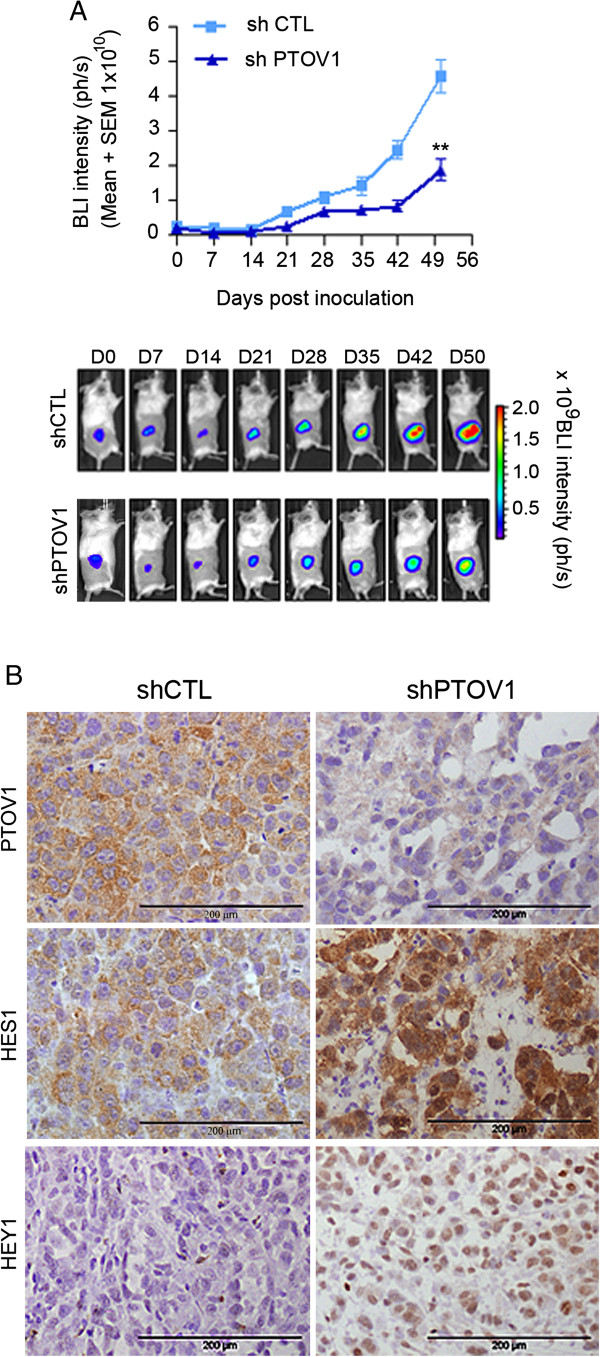
Knockdown of PTOV1 in prostate cancer cells inhibits tumor growth and metastasis of PC-3 cells in immunodeficient mice. (A) PTOV1 is required for optimal tumor formation of PC-3 cells in vivo. PC-3 cells with integrated luciferase gene (3 x106), knocked down for PTOV1 (n = 5) by sh1397 or control lentivirus (n = 5), were implanted subcutaneously into the right flank of SCID-beige male mice and monitored by in vivo bio-luminescent imaging. Mean values + SEM are displayed. Statistically significant differences in the growth of knockdown vs. control cells were observed. ** p = 0.001. (B) Immunohistochemistry of explanted tumors. A strongly decreased expression of PTOV1 is detected in tumors formed by shPTOV1 cells vs shControl derived tumors. In contrast, tumors derived from shPTOV1 cells express high levels of HES1 and HEY1 proteins compared to shControl and grew metasases at significantly later times (p = 0.001) as compared to control cells.